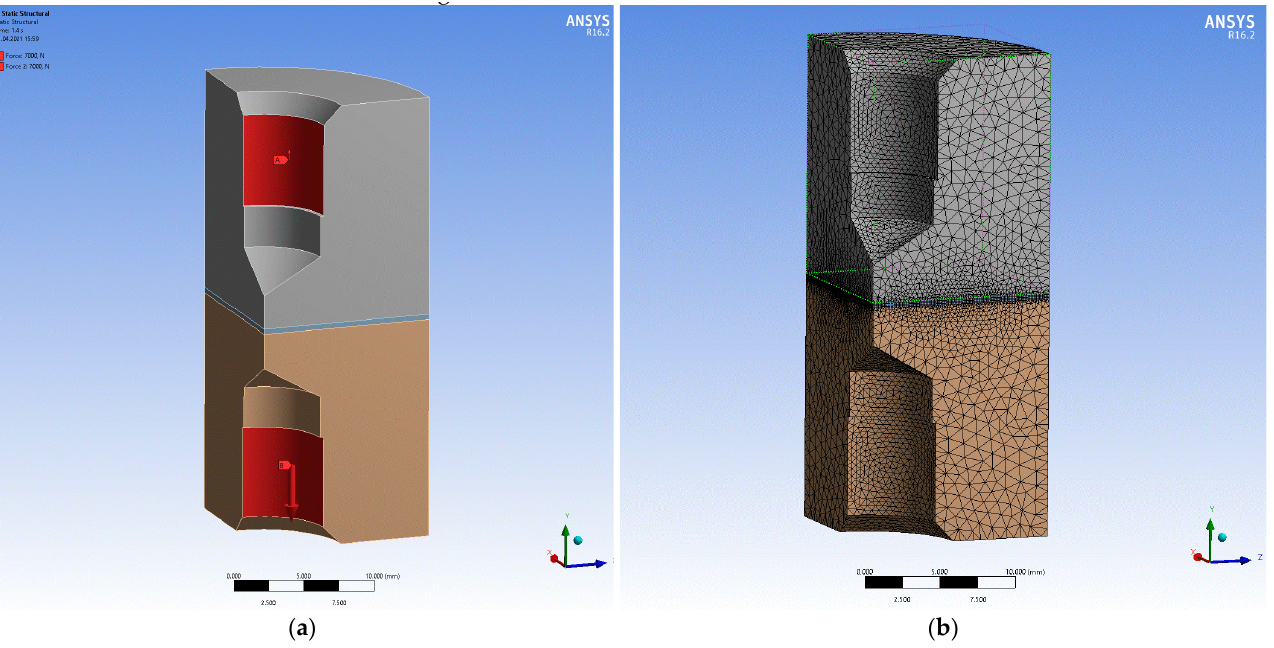
Figure 4. The axisymmetric finite element model for the standard specimen (type 1): ( a ) the finite element of two identical cylindrical halves bonded together with ceramic coating, GOST 9.304-87; ( b ) the 3-D finite element model grid.